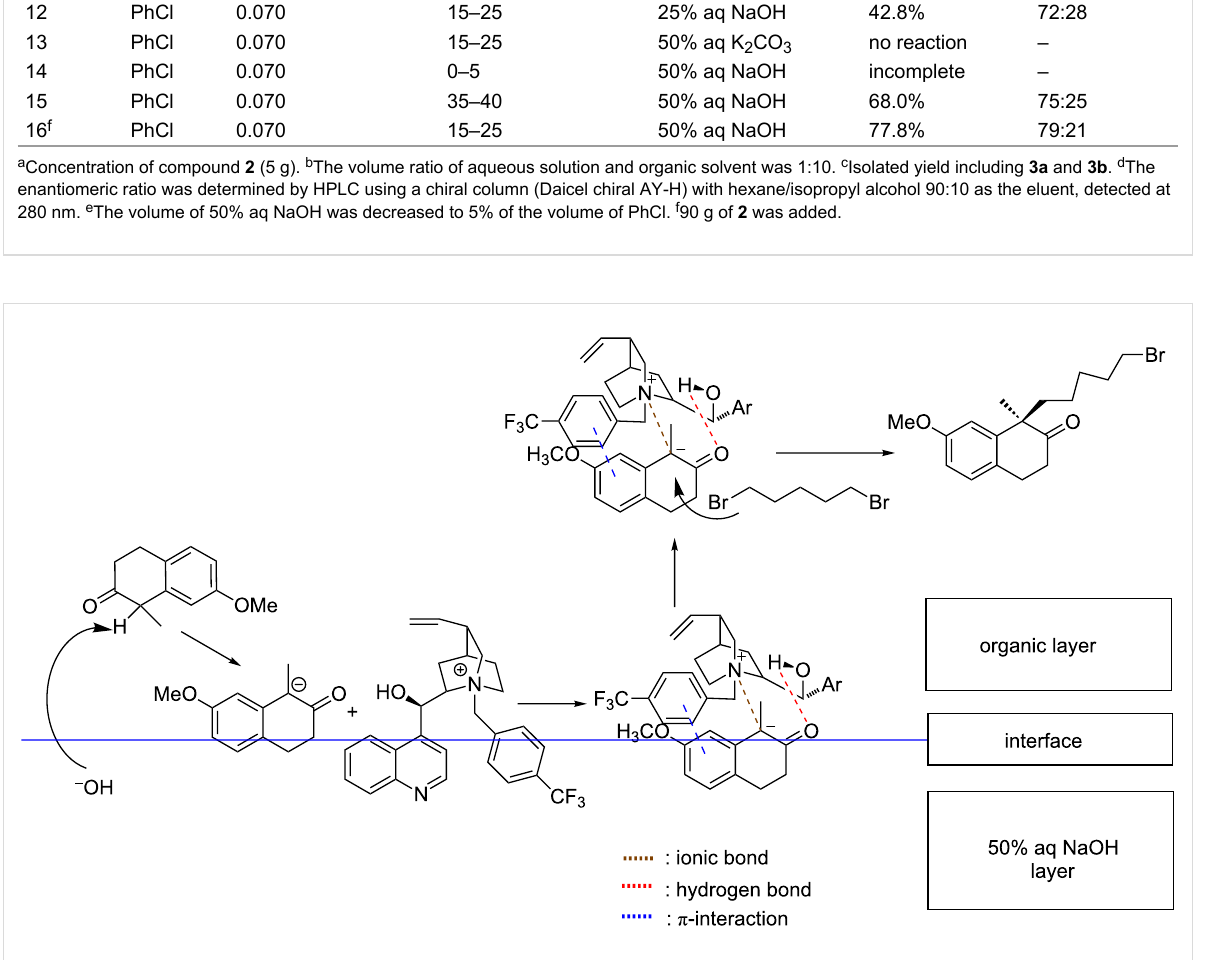
face π -stacking interaction with the benzyl moiety of C7 . The complex of 2 with C7 goes to the organic phase. Due to the sterical hindrance from the benzyl group, the alkylation by 1,5- dibromopentane takes place at the opposite side of the benzyl group of C7 to afford 3a